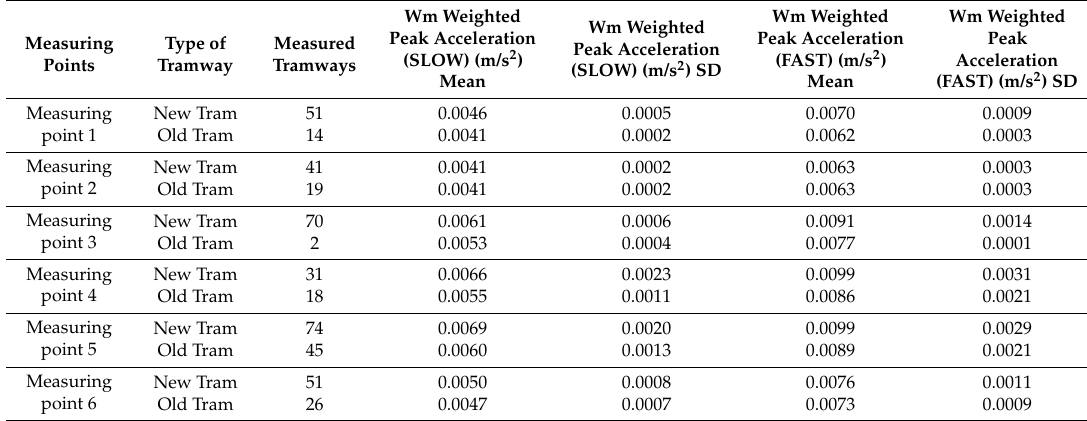
Table A1. Vibration exposure of analyzed tramways by tram type and time weighting.